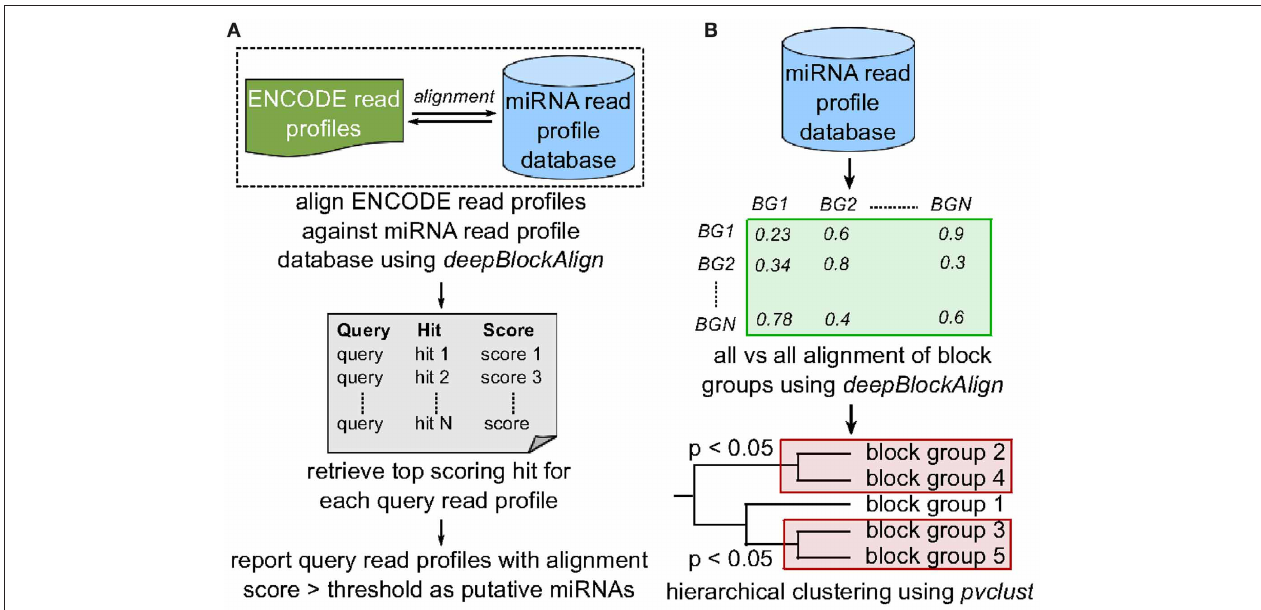
deepBlockAlign to generate an alignment score matrix. Next, we perform hierarchical clustering of block groups based on their alignment score using pvclust . pvclust computes the p -value for each cluster in hierarchical clustering using multiscale bootstrap resampling and indicates how strong the cluster is supported by the data. We select all the clusters with p < 0 . 05 that represent families of microRNAs that share similar read